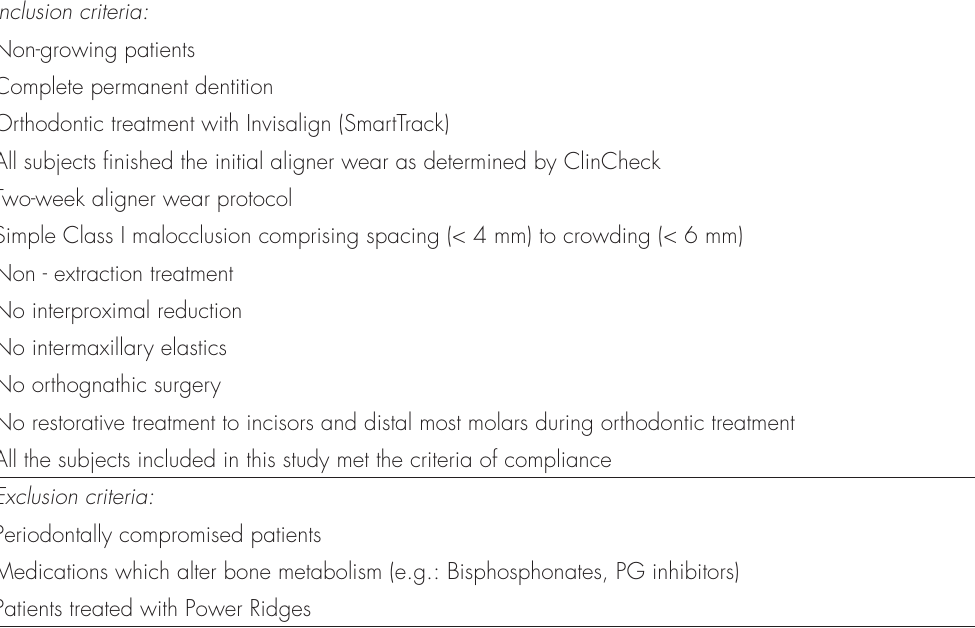
Table I. Criteria for sample selection.